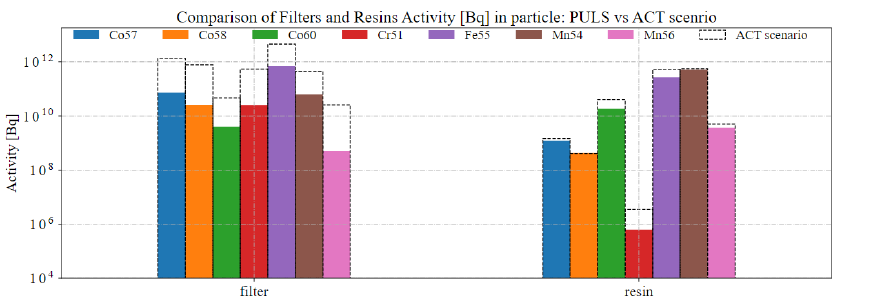
Figure 7. EU-DEMO Divertor cassette PHTS filters and resins deposit activities at the end of the operation scenario. Comparison between the pulsed and the activation